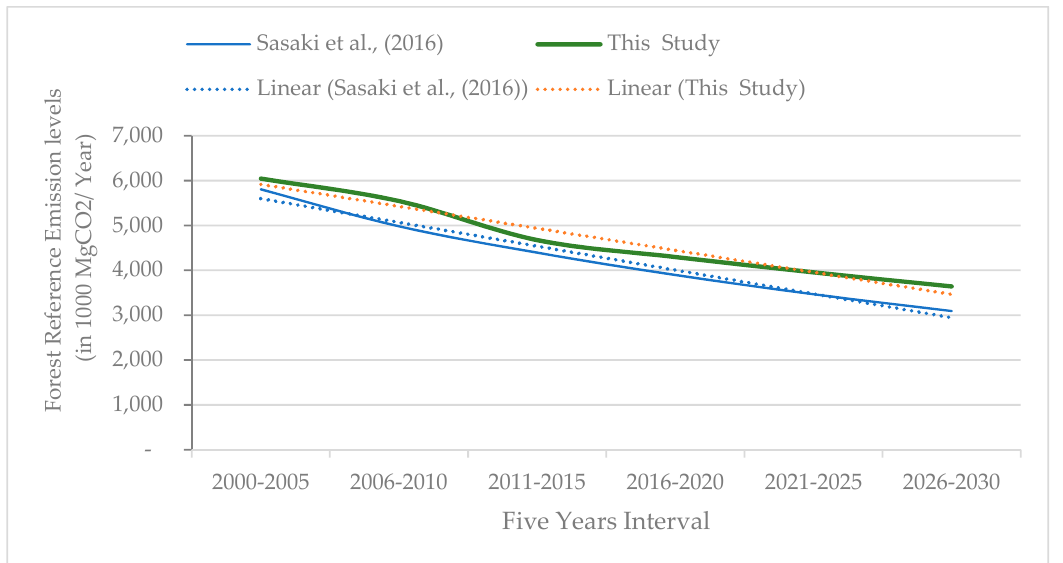
Figure 9. Validation of annual forest reference emission levels. Linear fitted line for this study: y = − 490.71 * x + 6410.4, R² = 0.9651. Linear fitting line for Sasaki et al. [10]: y = − 531.82 * x + 6133.8, R² = 0.9793.